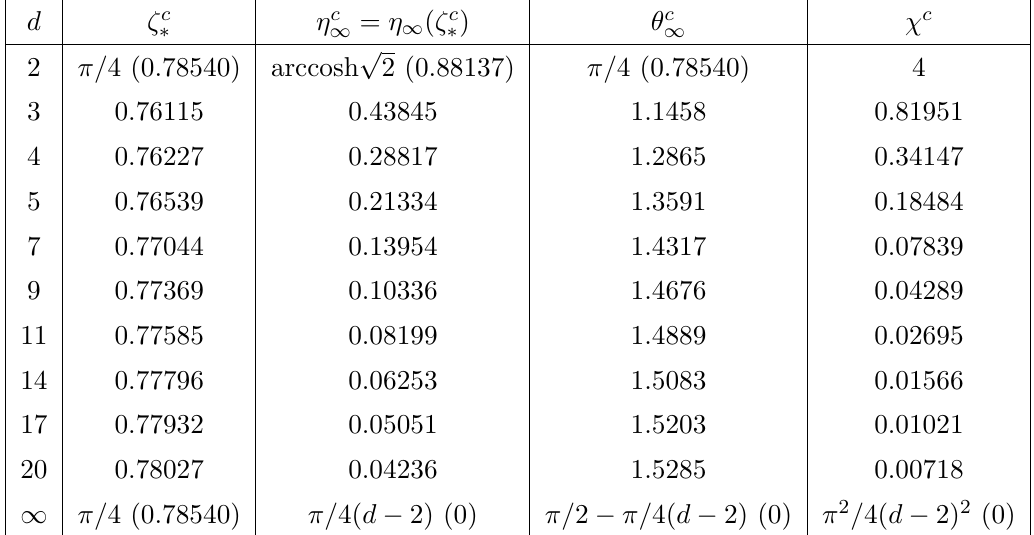
, (cid:17) c , (cid:18) c , and (cid:31) c for (cid:3) 1 1